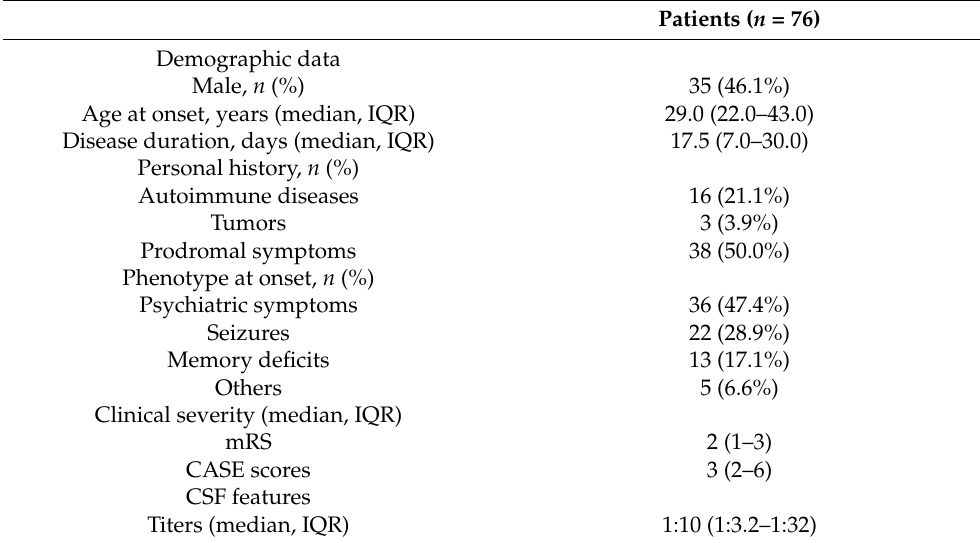
Table 1. Demographic and clinical characteristics of anti-NMDAR